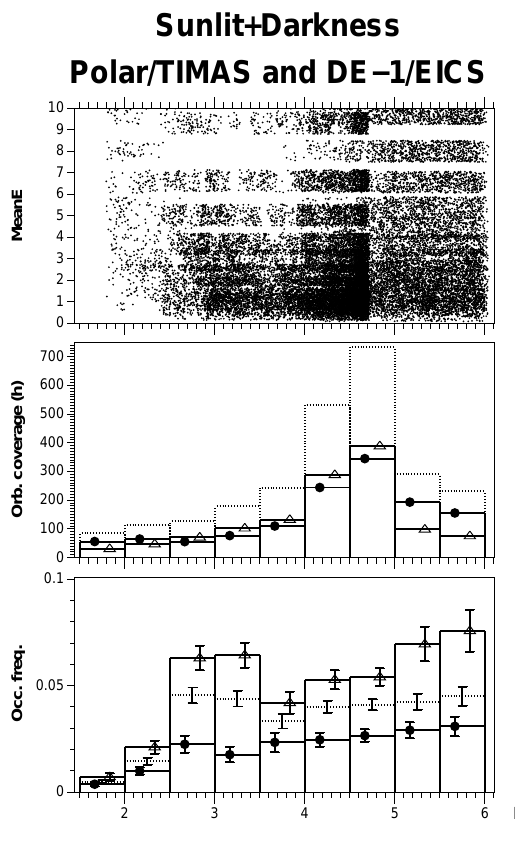
Fig. 3. Polar/TIMAS and DE-1/EICS ion beams in the nightside MLT sectors as a function of radial distance R . Top panel: Ion beam events (one event corresponds to 12s sample) as a function of radial distance and peak energy. Middle panel: Hours spent by the instrument in each radial bin. Bottom panel: Occurrence frequency of ion beams (number of points in each bin divided by the number of samples coming from the bin). Small K p ( ≤ 2) shown by filled circles, large K p ( > 2) by triangles. Dotted line is both K p s put together. All nightside MLT sectors (18–06) with both sunlit and darkness conditions are included. The ILAT range is